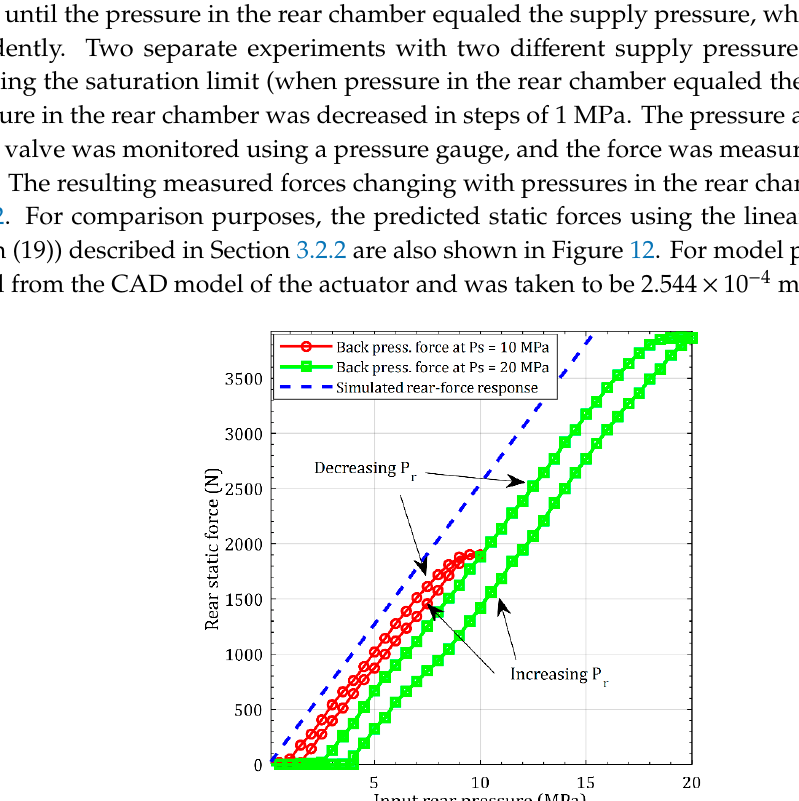
Figure 11. Comparison of the measured and theoretically predicted nonlinear static force characteristics of the actuator for flow control via servo valve.